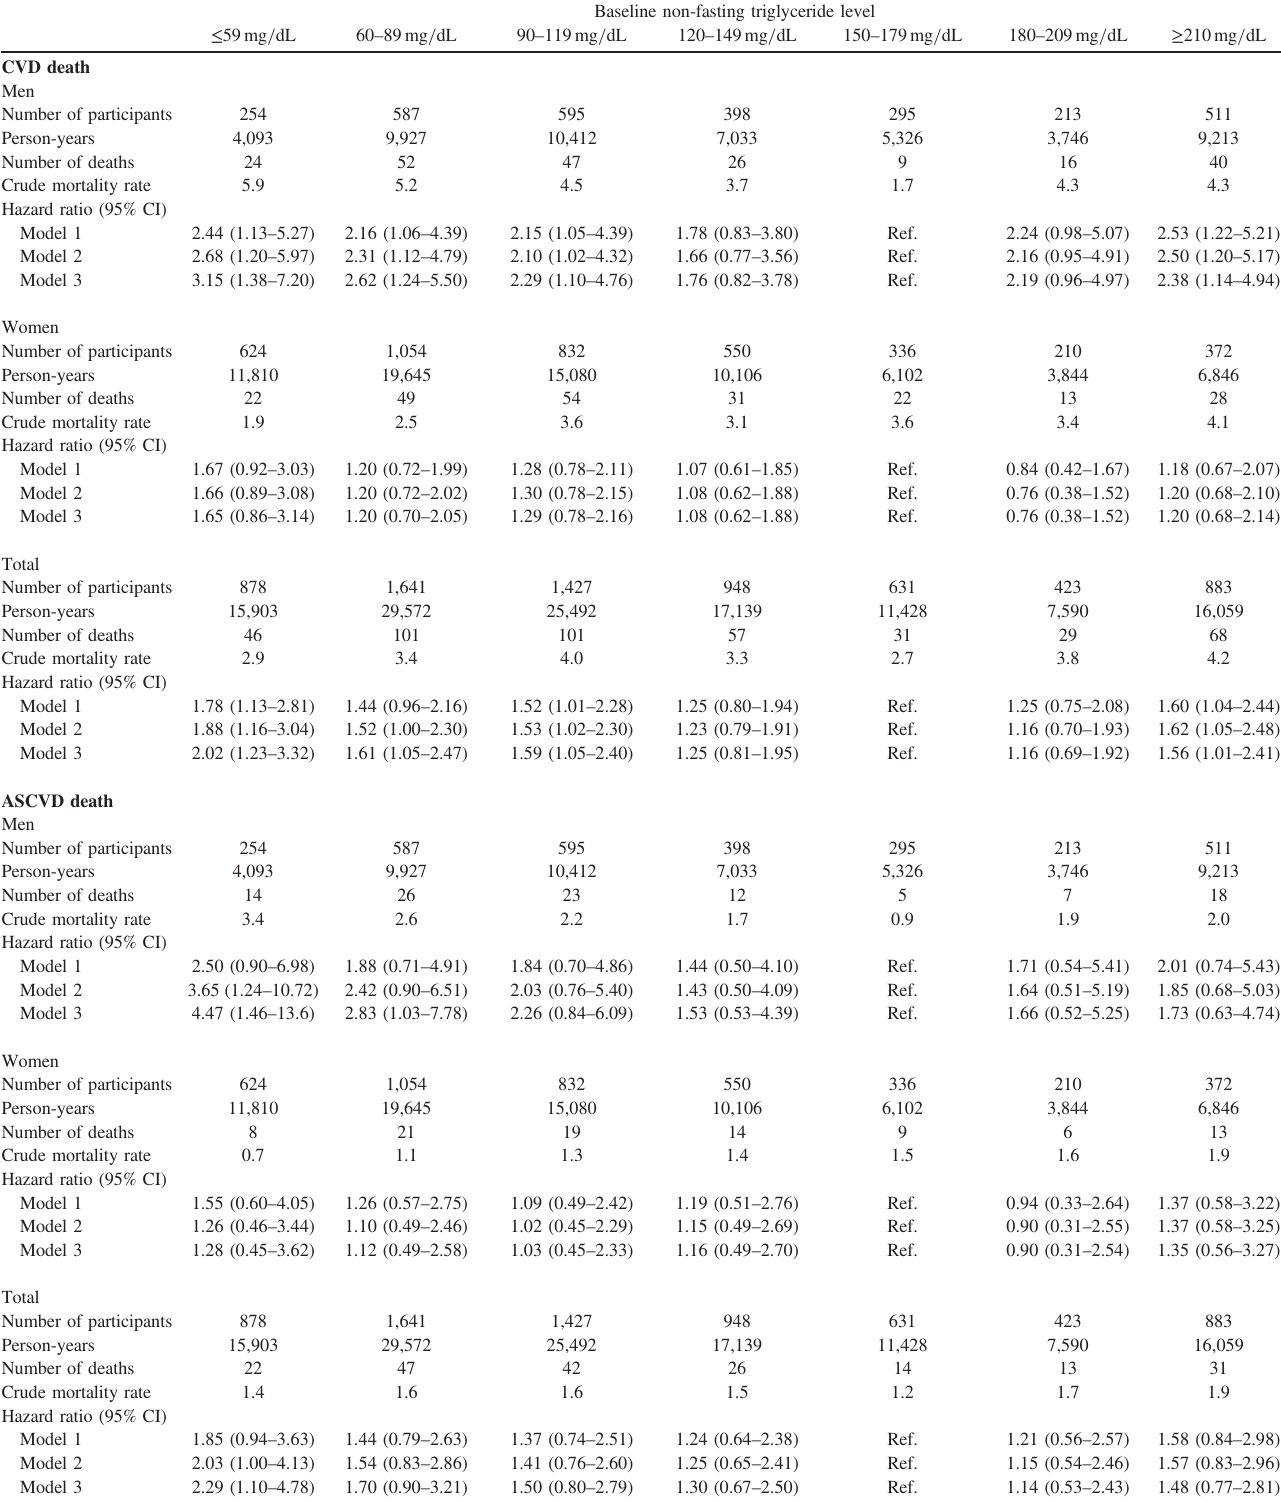
Table 3. Crude mortality rates and hazard ratios for CVD mortality and ASCVD mortality according to non-fasting triglyceride